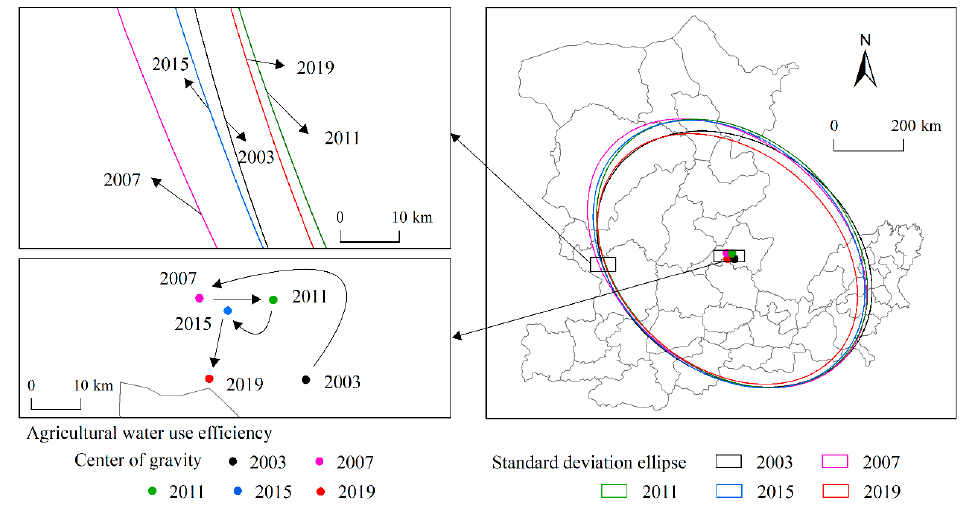
Figure 5. Trajectory of the center of gravity and standard deviation ellipse of agricultural water use efficiency.